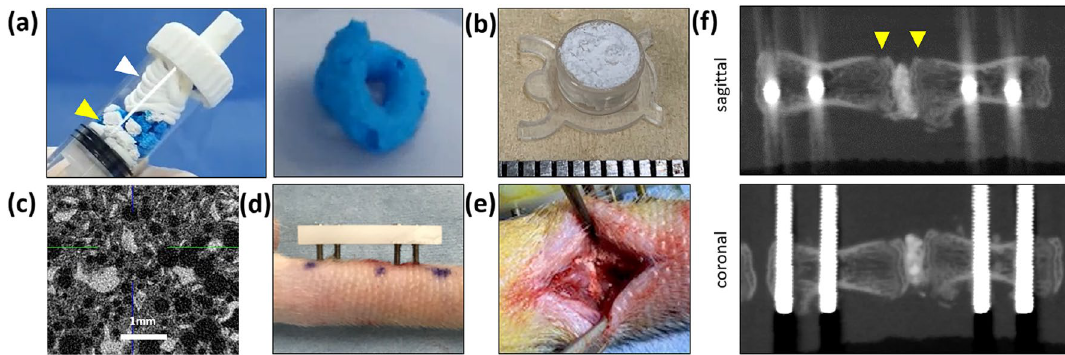
Figure 7. Process for the production of HA/β-TCP/hydrogel, operative photograph, and postoperative micro- computed tomography images. Preparation of HA/β-TCP/hydrogel loaded with rhBMP-2 ( a ), HA/β-TCP/ hydrogel used for insertion ( b ), ex-vivo μ-CT image of HA/β-TCP/hydrogel ( c ), caudal intervertebral fusion ( d ), and disc space after implantation of HA/β-TCP/hydrogel ( e ). Postoperative sagittal (f, upper) and coronal (f, lower) views of micro-CT, with yellow arrowheads indicating the surface of the bony endplate in the sagittal